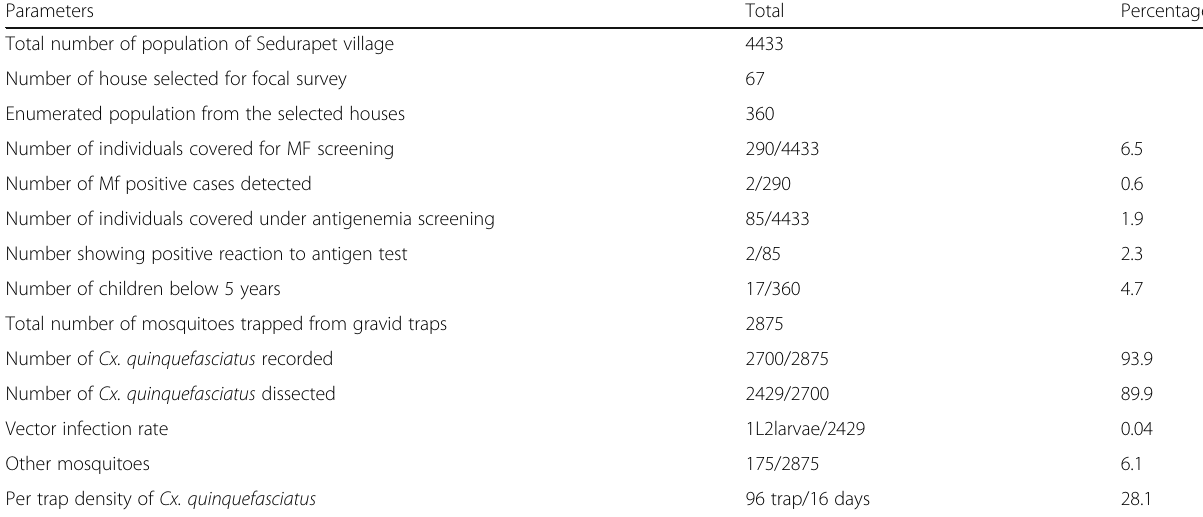
Table 1 Summary of infection and transmission parameters